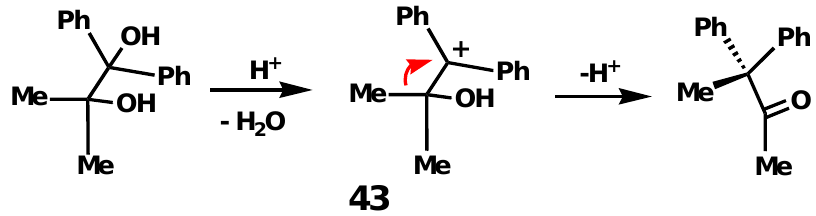
Scheme 11. Pinacol rearrangement showing methyl rather than phenyl migration.